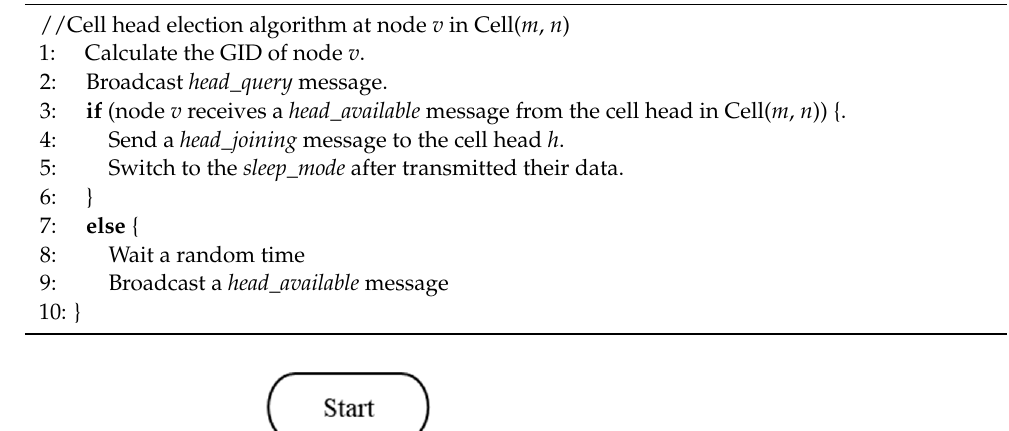
Algorithm 1: Cell Head Election Algorithm